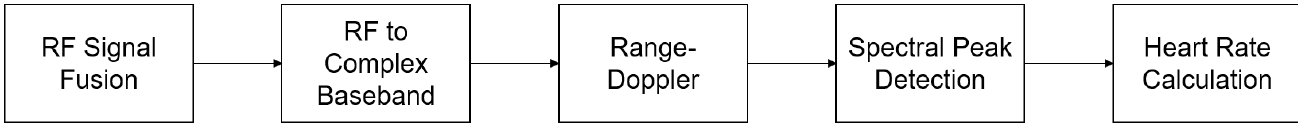
Figure 3. Block diagram showing the main processing steps to extract human subject’s heart-rate from radar